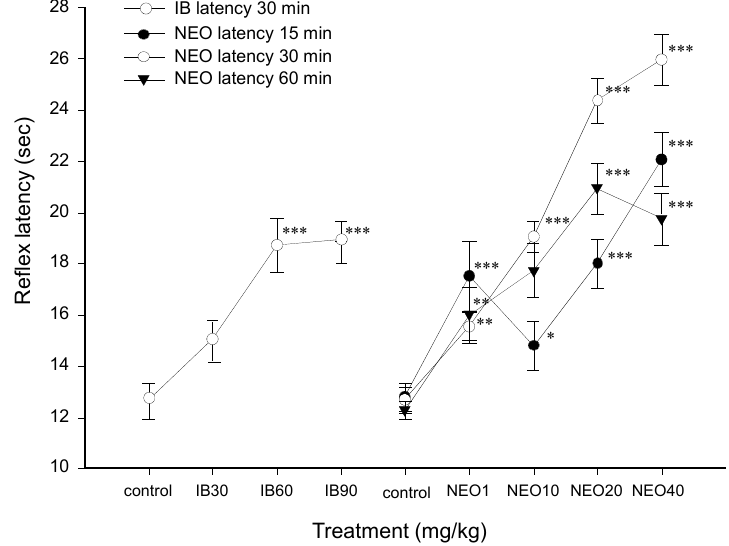
Figure 3. Effect antinociceptive of ibuprofen (IB) and NEO in the hot plate